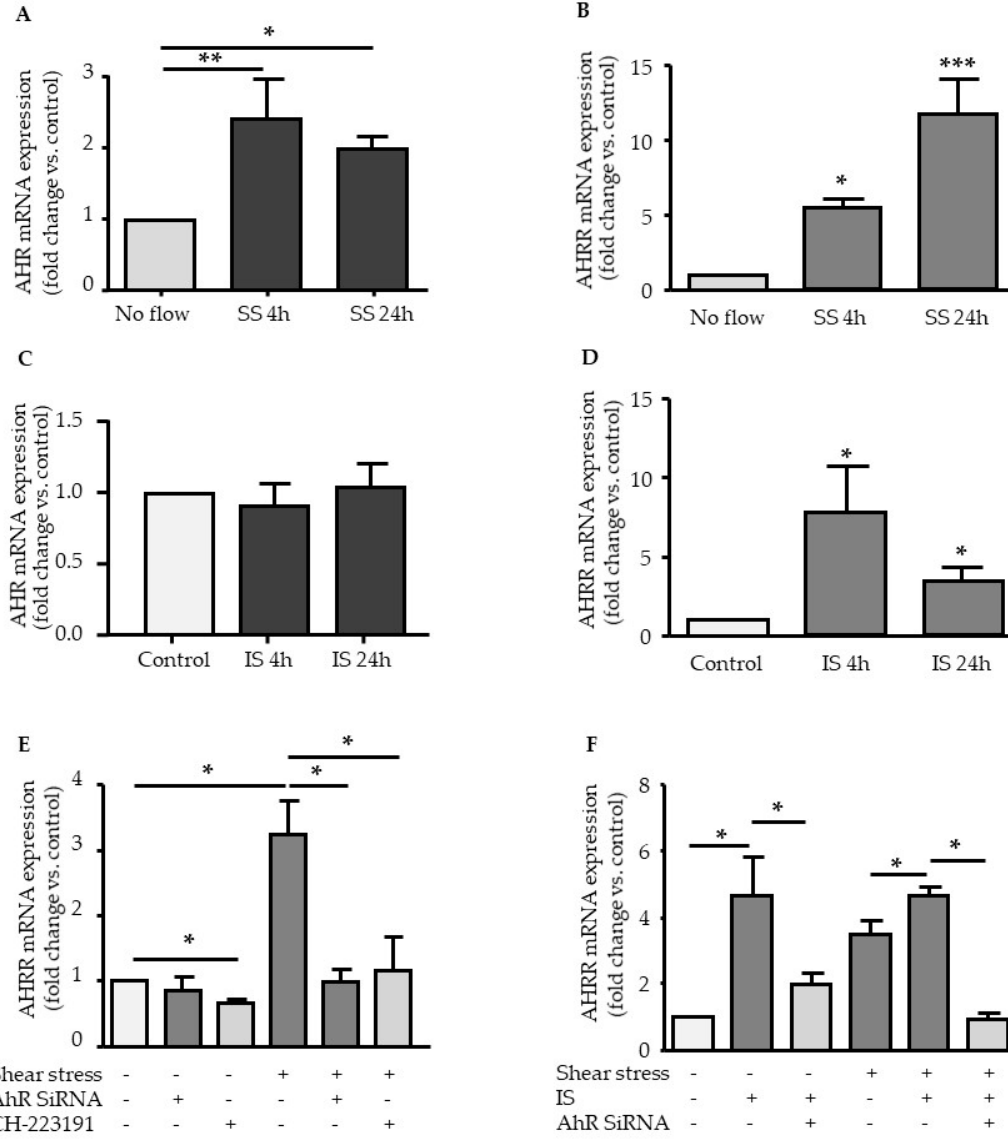
Figure 1. Effect of shear stress and indoxyl sulfate (IS) on aryl hydrocarbon receptor (AHR) and AHR-dependent AHR repressor (AHRR) expression. Effect of shear stress 5 dynes/cm 2 on AHR ( A ) and AHRR ( B ) mRNA expression. Data, expressed as fold change vs. control, represent the mean ± SEM of n = 7 independent experiments. Effect of IS 200µM on AHR ( C ) and AHRR ( D ) mRNA expression. Data, expressed as fold change vs. control, represent the mean ± SEM of n = 4 independent experiments. ( E ) Effect of the AHR inhibitor CH-223191 (10µM) and of AHR siRNA on AHRR mRNA expression after 4 h of shear stress. Data represent the mean ± SEM of 5 independent experiments. ( F ) Effect of AHR siRNA on AHRR mRNA expression after a 4 h stimulation with IS 200µM. Data represent the mean ± SEM of 6 independent experiments. * p < 0.05, ** p < 0.01, *** p < 0.001. The role of AHR in upregulation of AHRR mediated by shear stress was studied using small interfering RNA knockdown of AHR (AHR siRNA) and the AHR inhibitor CH223191. AHR siRNA and CH223191 strongly inhibited shear stress-induced upregulation of AHRR (Figure 1E). When endothelial cells were stimulated with IS under shear stress conditions (Figure 1F), IS slightly amplified shear stress-induced mRNA expression of AHRR (Figure 1F). AHR inhibition by